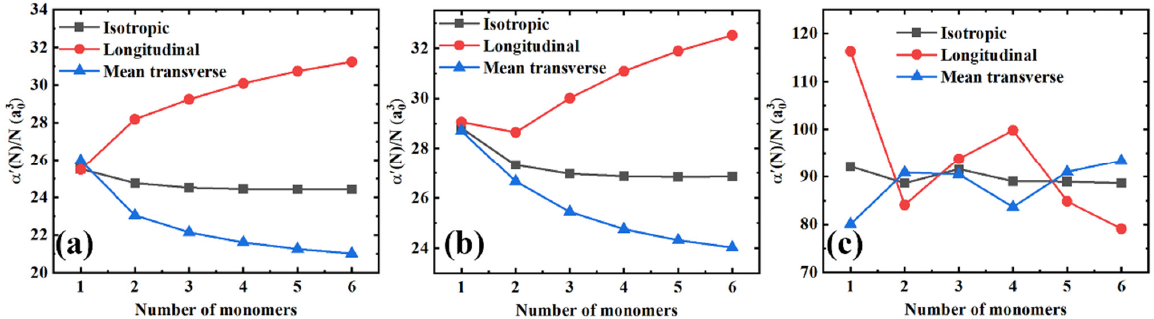
Figure 3. The isotropic, longitudinal, and mean transverse polarizabilities per monomer unit as a function of the number of monomers for different polymer materials. ( a ) PE; ( b ) PTFE; and ( c ) PS.